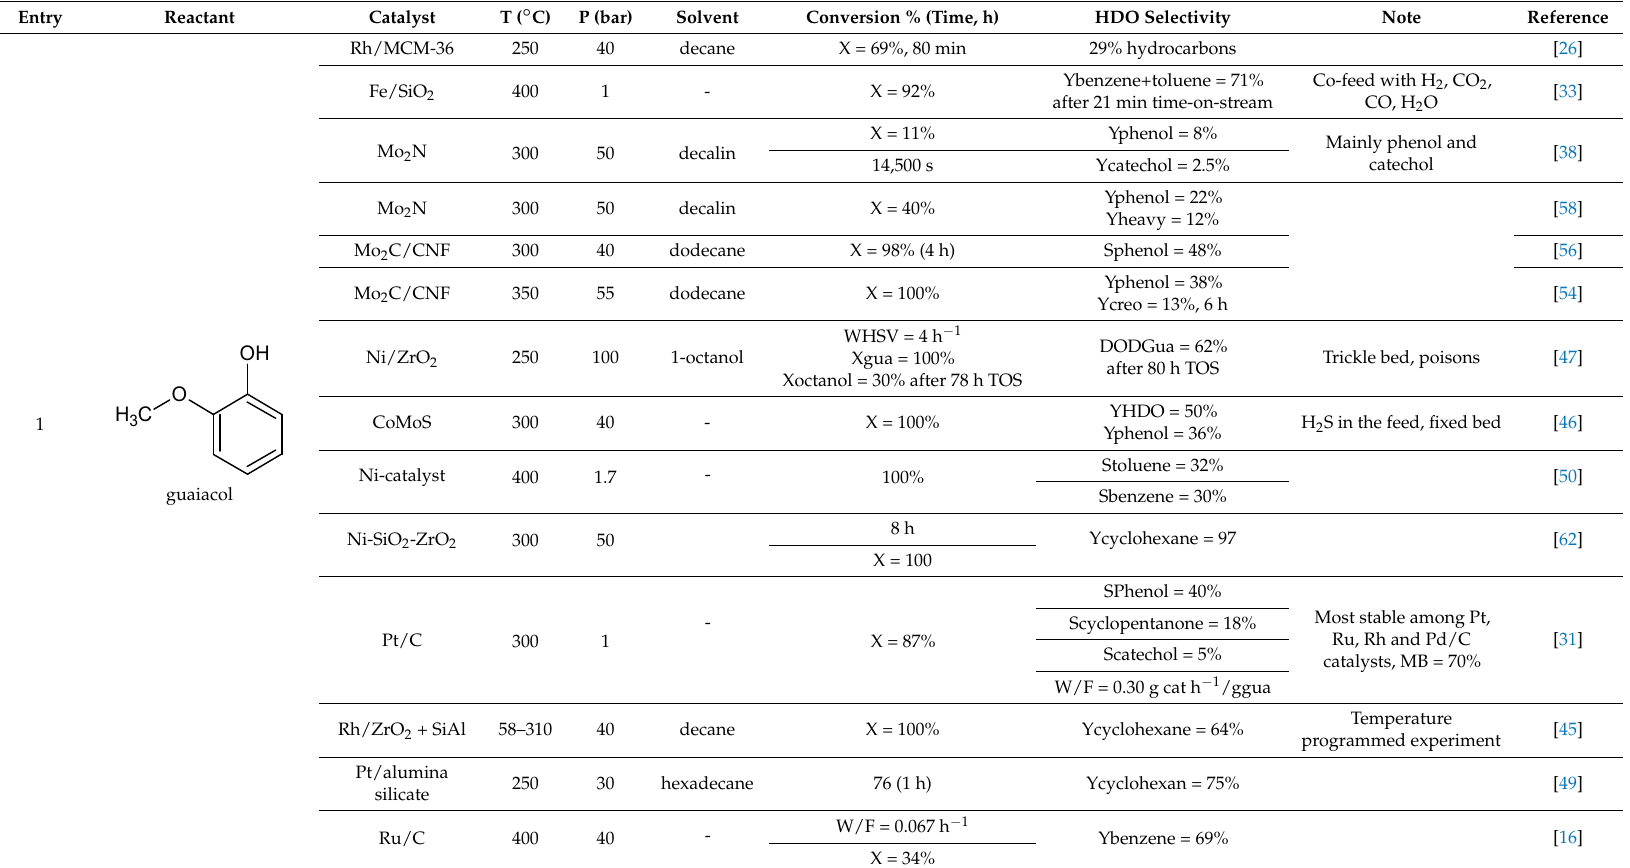
Table 1. Single model molecule feed HDO results. Notation: Y denotes yield and S selectivity. X is conversion.